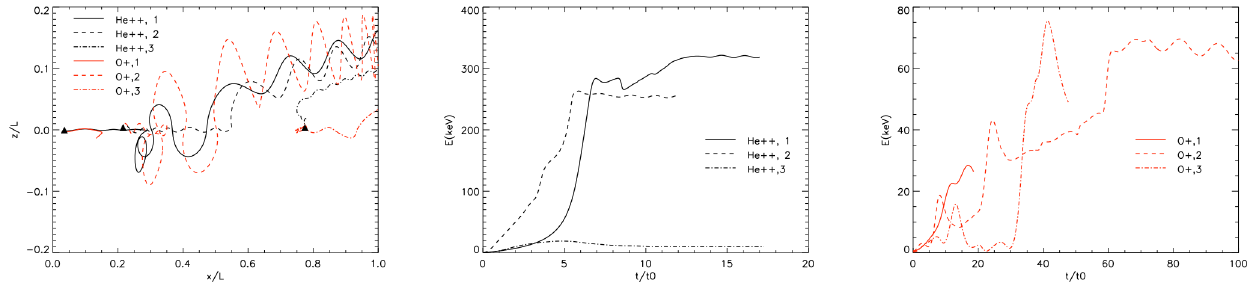
Figure 5. Trajectories and energies of He ++ and O + ions in the presence of B x (z) as in profile 1. Black lines represent the He ++ ions and red lines the O + ions (solid line for particle 1, dashed line for particle 2, dashed-dotted line for particle 3). The triangles denote the starting point.